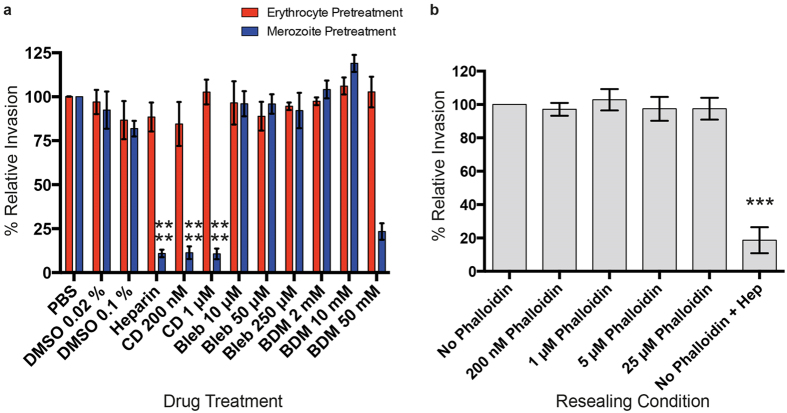
Effect of actin and myosin inhibitors on merozoite invasion.(a) Merozoite invasion when either erythrocytes or merozoites were pre-treated with cytochalasin D (CD), blebbistatin (bleb) or BDM. Invasion percentage is expressed relative to the new ring parasitemia of control cells that were incubated in either PBS alone (for DMSO, heparin and myosin inhibitor treatment) or DMSO (for cytochalasin D treatment). ****p < 0.0001, ***p <0.01, two-tailed unpaired t-test. Graph displays mean +/− SEM. n = 3 in triplicate for all samples except BDM at 10 mM and 50 mM, which was performed three times in either duplicate or triplicate. (b) Invasion rate into erythrocytes resealed in the presence of different concentrations of phalloidin, where invasion is expressed as a percentage relative to the new ring parasitemia of control cells that were resealed in the absence of phalloidin. Graph displays mean +/− SEM, n = 3 in triplicate.